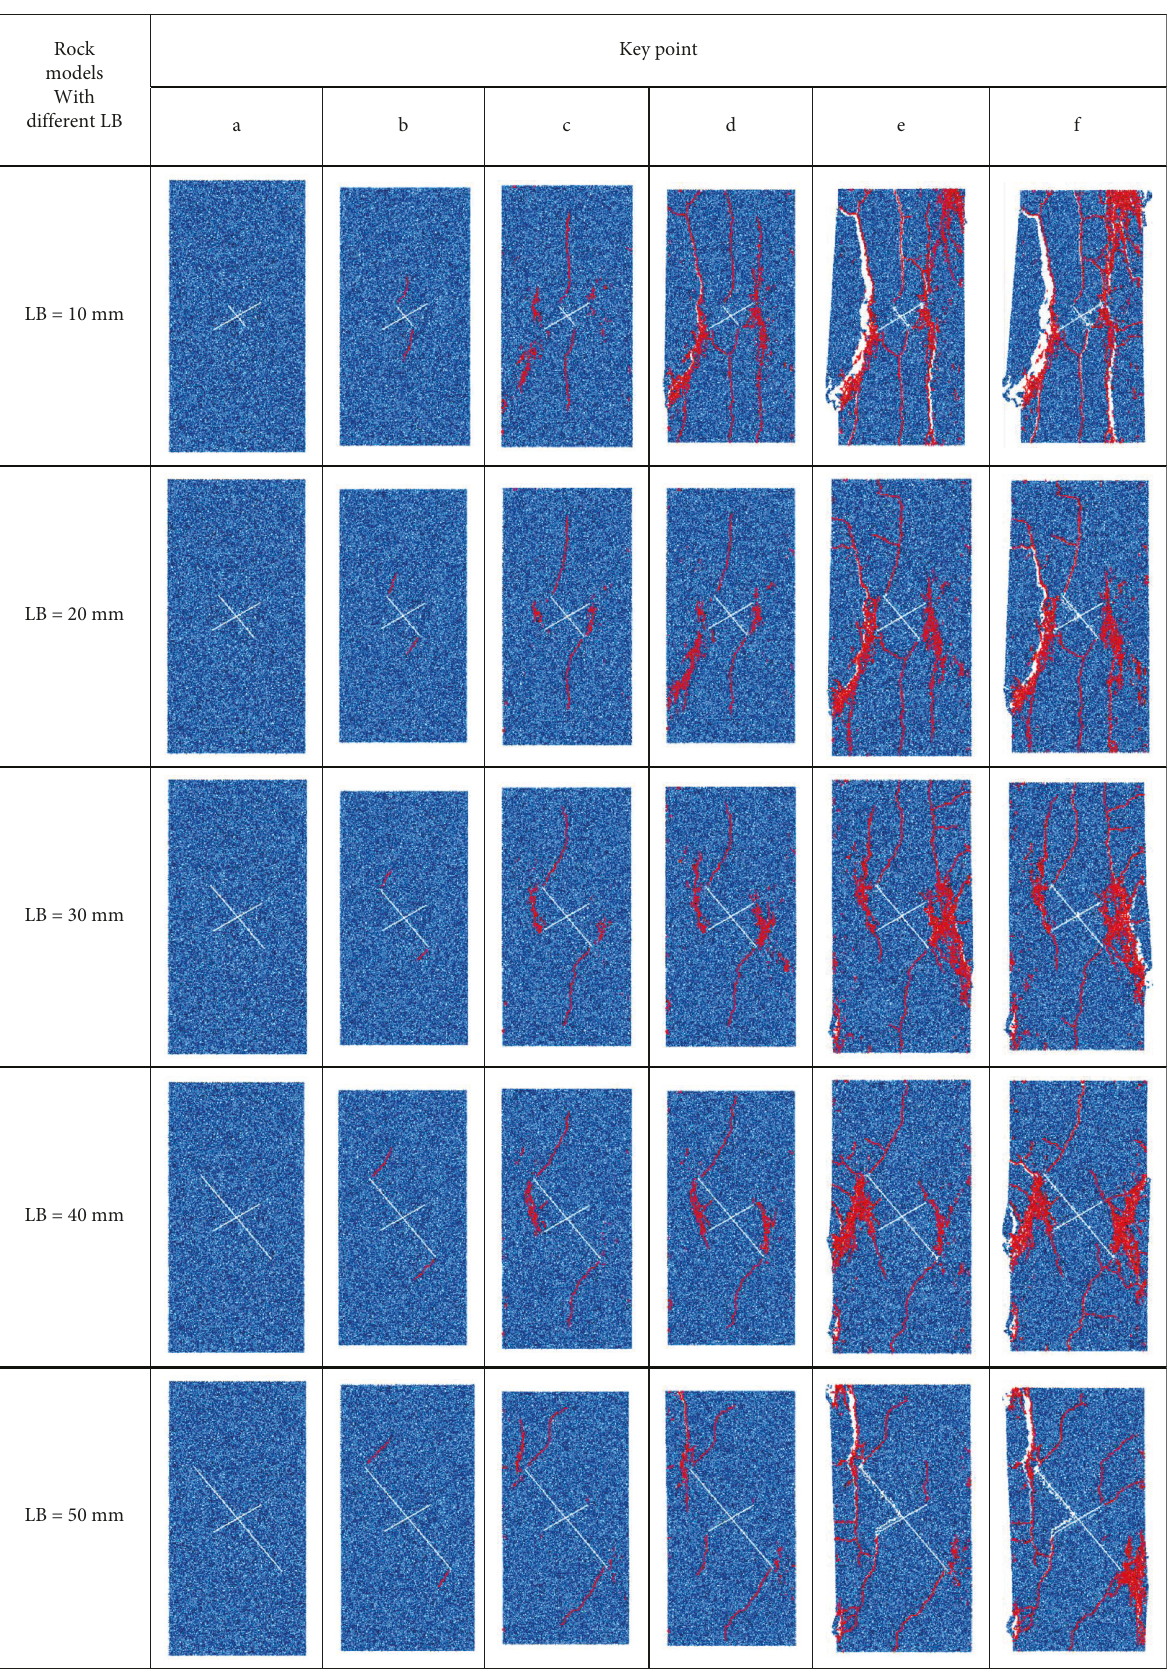
Figure 13: Damage evolution of rocks with different joint